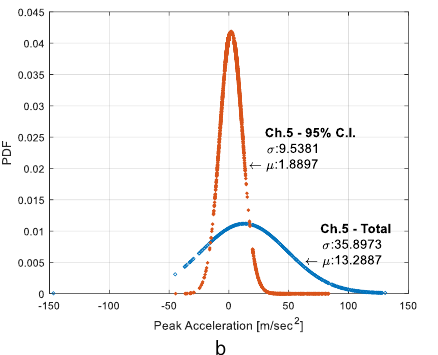
Figure 10 Comparison of the PDFs by the raw data set with the signals within 95% confidence interval: a. AM3 and b. Ch.5 (AT)